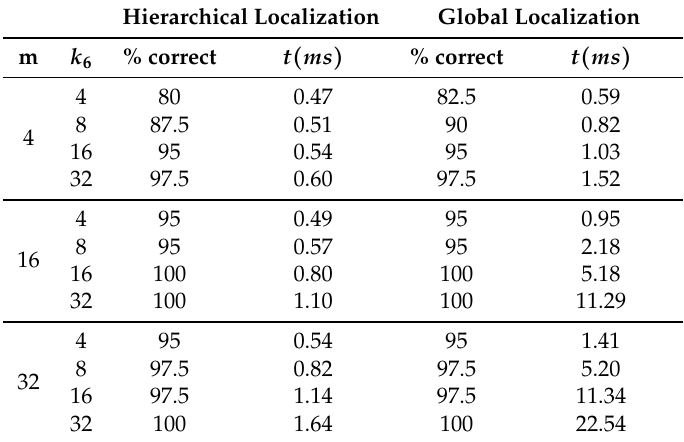
Table 6. Results of the localization process using the gist descriptor. Comparative between hierarchical and global localization. Percentage of correct localizations and average time to obtain a